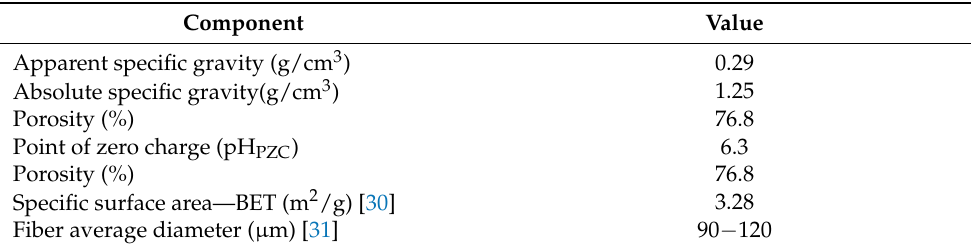
Table 3. Principal characteristics of Alfa leaf powder